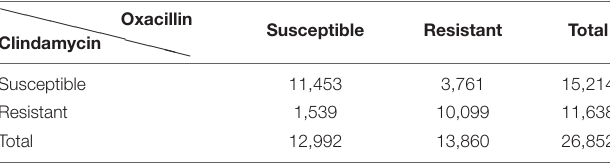
TABLE 2 | Susceptibility information for clindamycin and oxacillin in the Kaohsiung cohort.